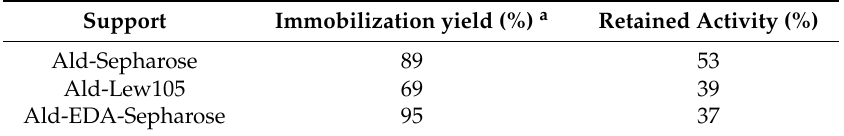
Table 1. Covalent immobilization of Candida rugosa lipase on different supports at 4 ˝